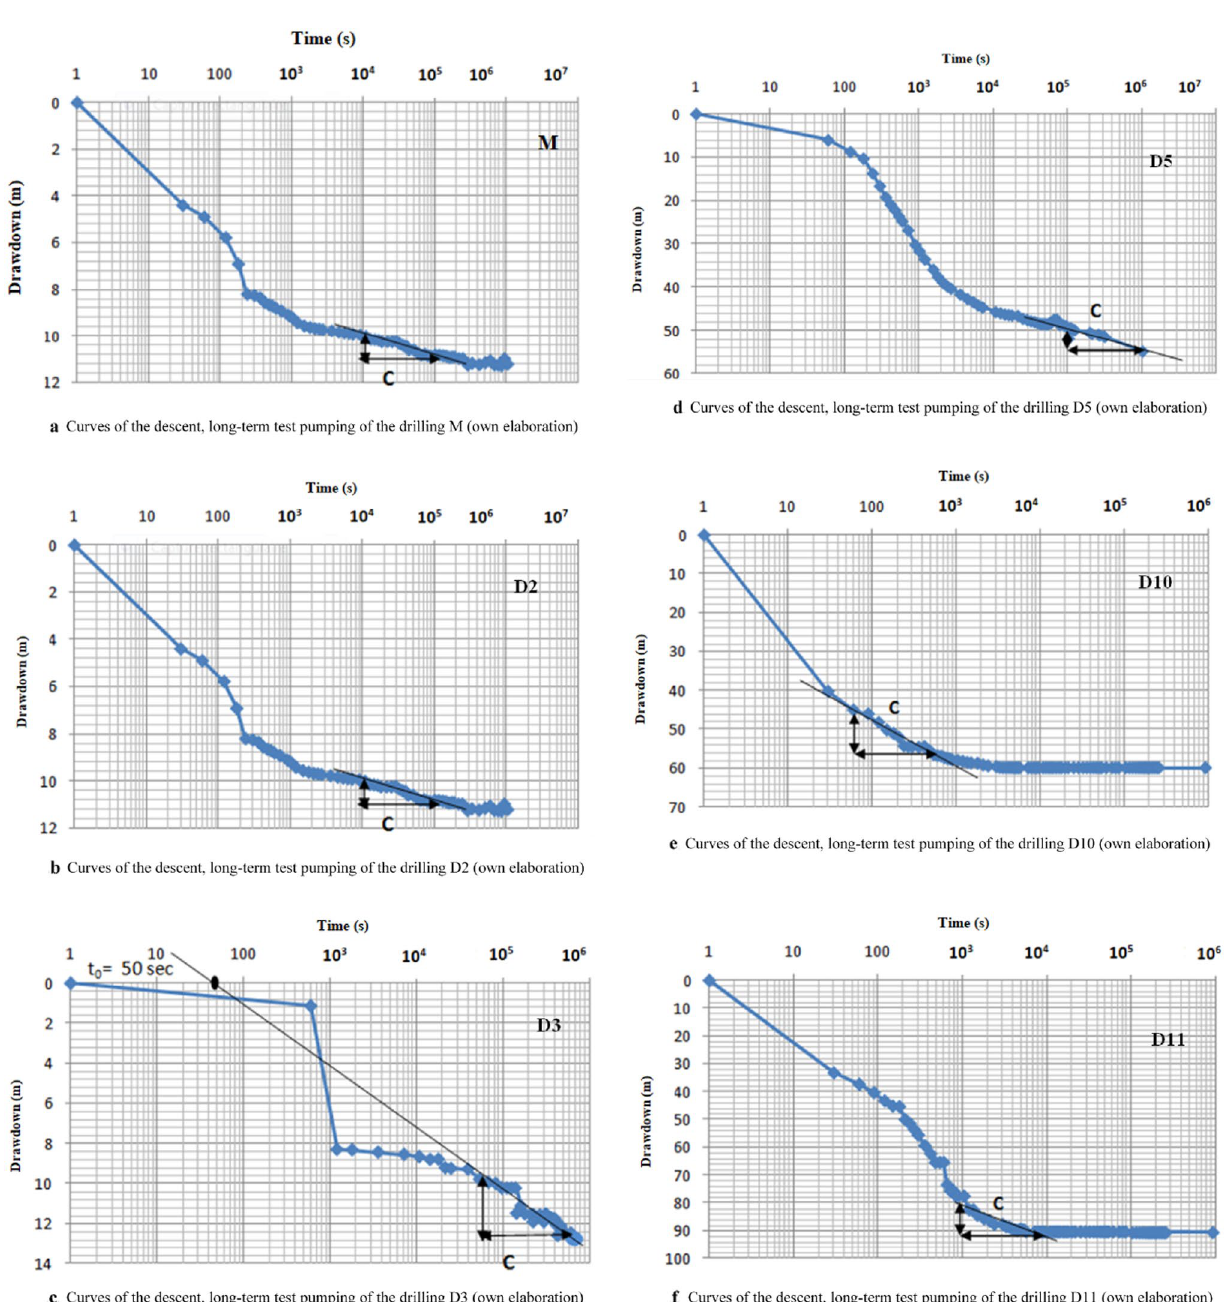
Fig. 6 a Curves of the descent, long-term test pumping of the drill- ing M (own elaboration), b Curves of the descent, long-term test pumping of the drilling D2 (own elaboration), c Curves of the descent, long-term test pumping of the drilling D3 (own elaboration),